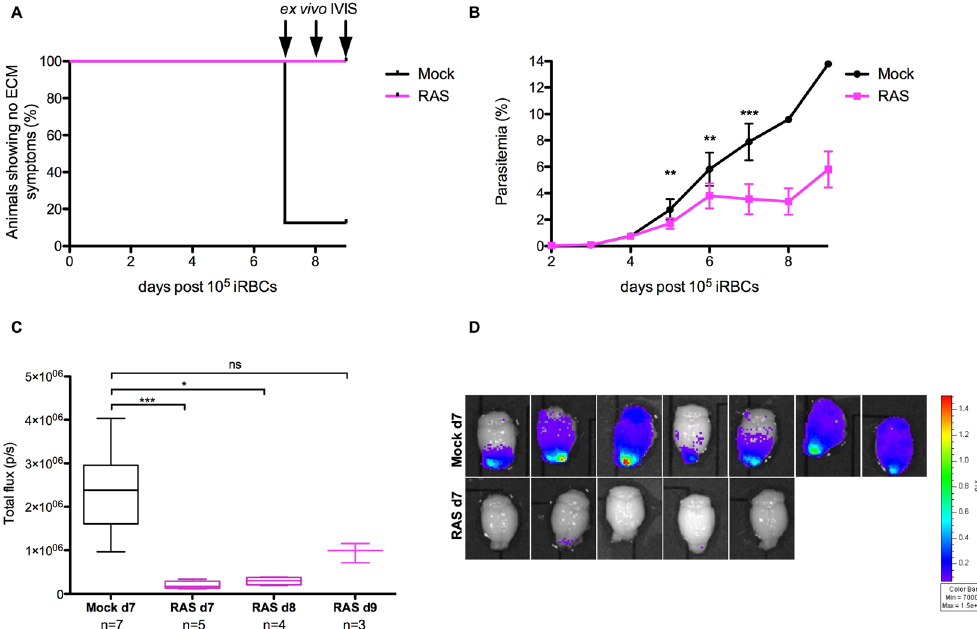
Figure 4. Parasite sequestration in the brain differs between Mock-control and one-shot RAS-immunized mice after iRBC challenge. C57BL/6 J mice were immunized with one-shot of 3 × 10 4 RAS (n = 12) or salivary gland debris (Mock; n = 8) and challenged 6 weeks later with 10 5 iRBC of Pb GFP Luc con WT parasites. ( A ) One- shot RAS-immunized and iRBC-challenged animals do not develop ECM. ( B ) Delayed blood-stage growth in one-shot RAS-immunized animals compared to Mock-control mice after a challenge with 10 5 iRBCs. For statistical analysis, a Mann-Whitney Test was applied; day 5, P = 0.002; day 6, P = 0.002 and day 7, P = 0.0002). ( C ) From day 7 to day 9 after infection, one-shot RAS-immunized mice showed a significantly reduced brain parasite load after a challenge with 10 5 iRBCs. Groups of mice were sacrificed at the day when Mock-injected mice showed ECM (day 7 after challenge; n = 7 for Mock-injected mice and n = 5 for one-shot RAS-vaccinated mice). For RAS-vaccinated animals, additional groups of mice were sacrificed at day 8 (n = 4) and day 9 (n = 3) after challenge. Bioluminescence was recorded as total flux (photons (p)/second (s)). Statistical analysis was performed using Kruskal-Wallis with Dunn’s Multiple Comparison Test ( *** p < 0.001; ** p < 0.01; ns, not significant). ( D ) Ex vivo bioluminescence images from RAS and Mock animals at day 7 after challenge. Note the increased bioluminescence signal in ECM-affected Mock animals, which is notable particularly in in the olfactory